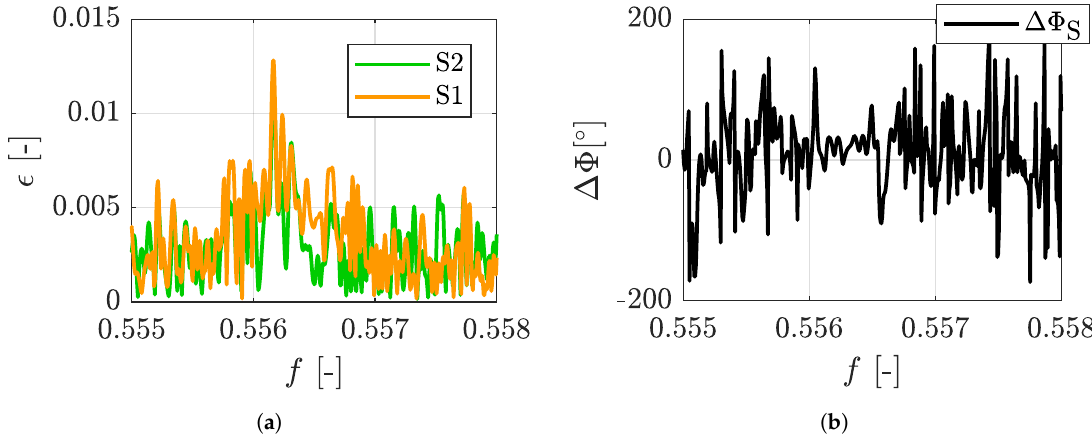
Figure 8. Vibratory Mode 5: Shaft vibrations, frequency domain and phase lag. ( a ) Normalized amplitude of both shaft SGs during resonance M5; ( b ) Phase lag ∆ Φ S of shaft SGs during resonance